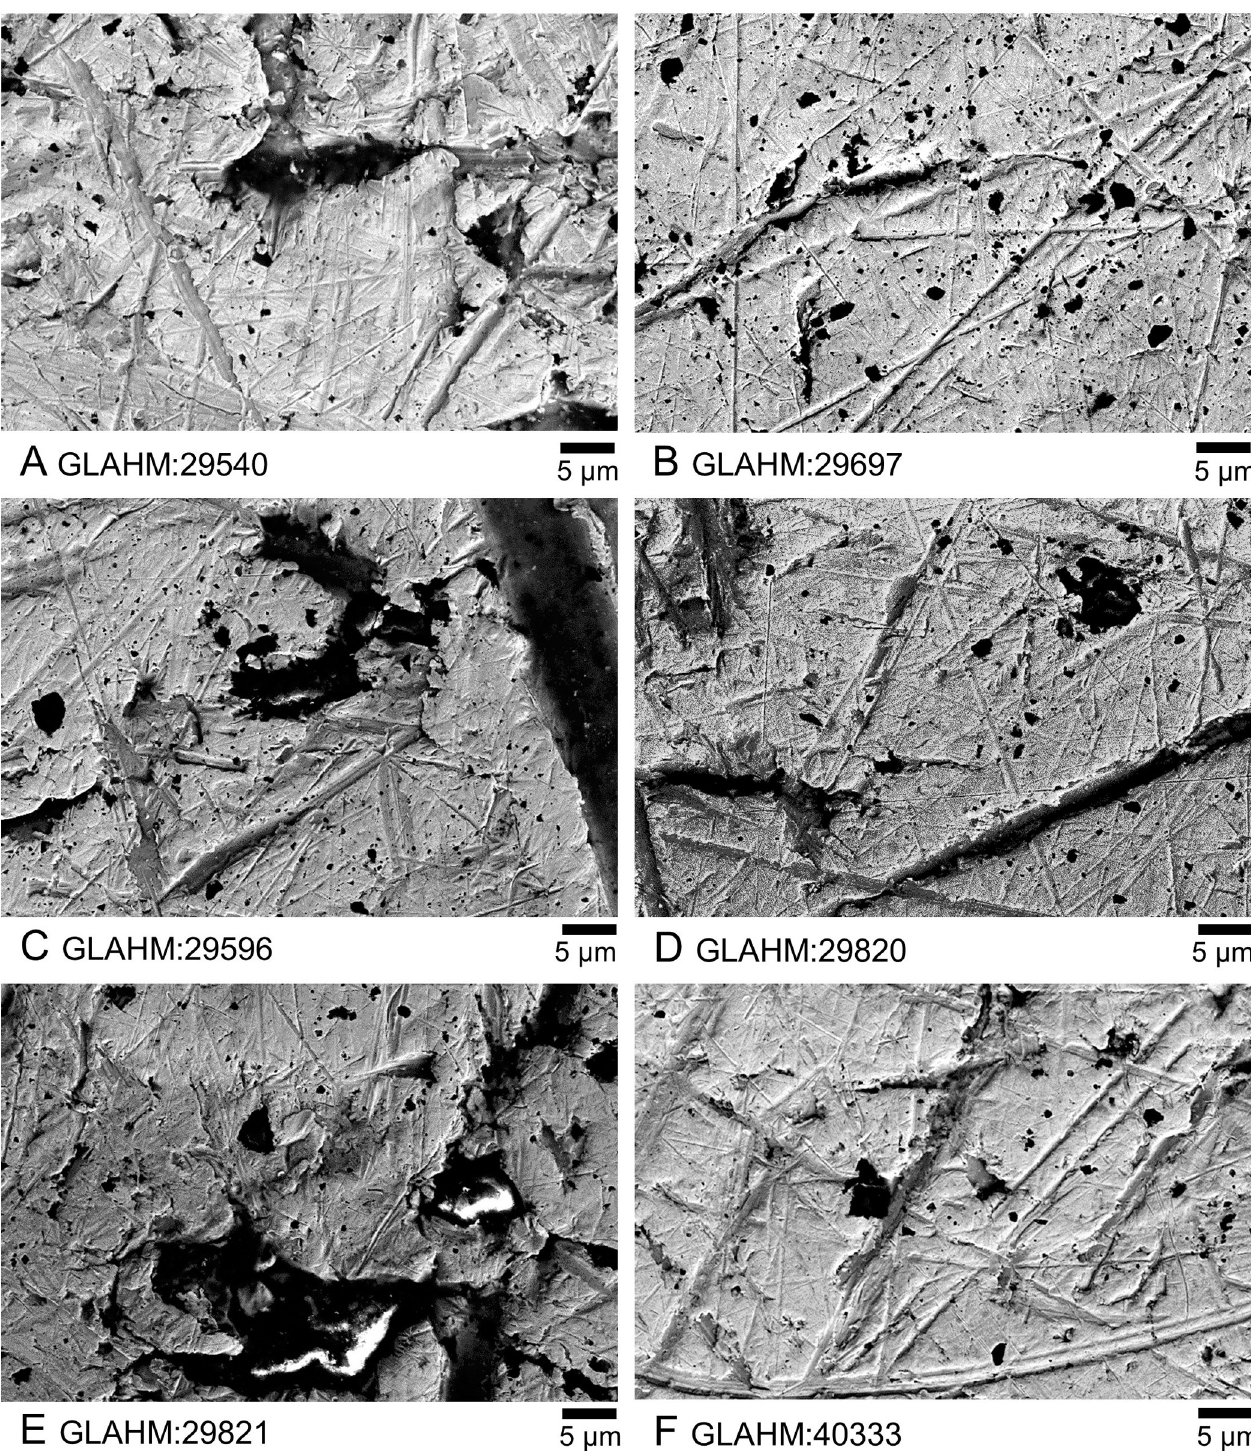
Fig 7. High magnification electron microscope images of exposed upper areas on the obverse of the six coins. The two unquestionably genuine coins are at the top: A) GLAHM:29540; B) GLAHM:29697; C) GLAHM:29596; D) GLAHM:29820; E) GLAHM:29821; F) GLAHM:40333.